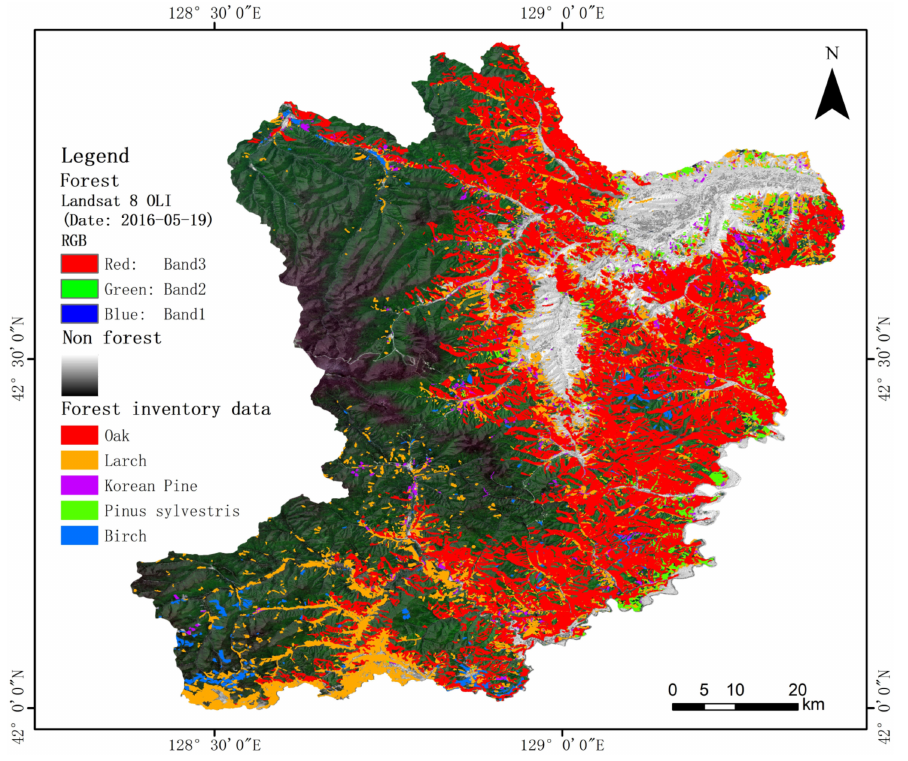
Figure 4. Forest inventory data of the study area in 2016.